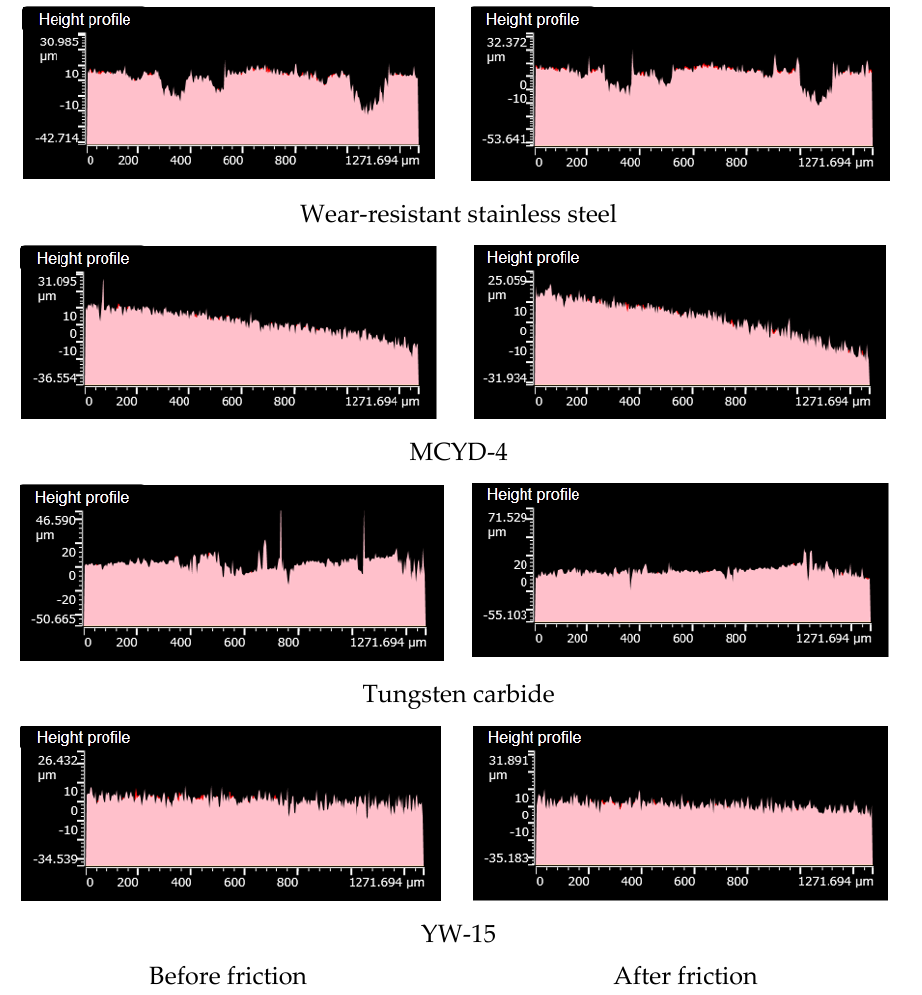
Figure 12. Height profiles before and after the friction between different metals with NR/BR composites.